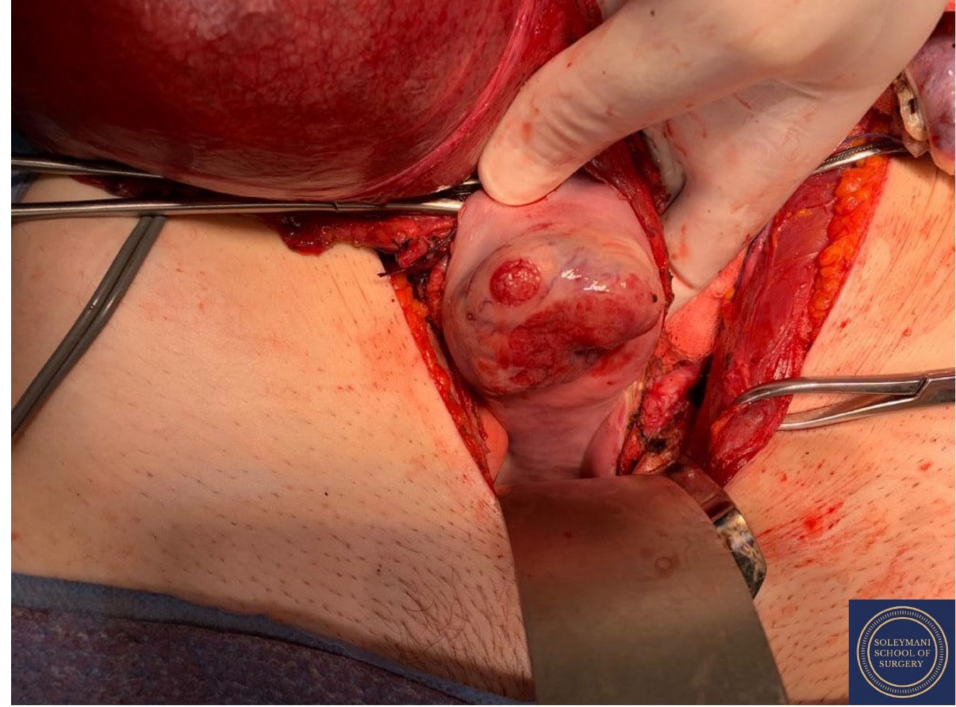
Figure 15. Upper vaginectomy ensuring an appropriate excision